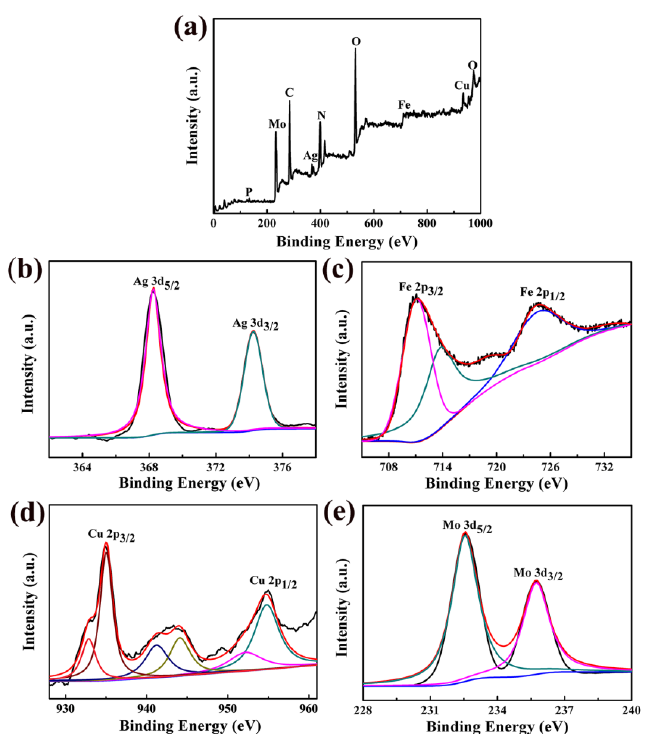
Figure 2. X-ray photoelectron spectrometer (XPS) spectra of Fe 3 O 4 /Ag/POMs nanocomposites: ( a ) full spectrum, ( b ) Ag 3d map, ( c ) Fe 2p map, ( d ) Cu 2p map, ( e ) Mo 3d map.